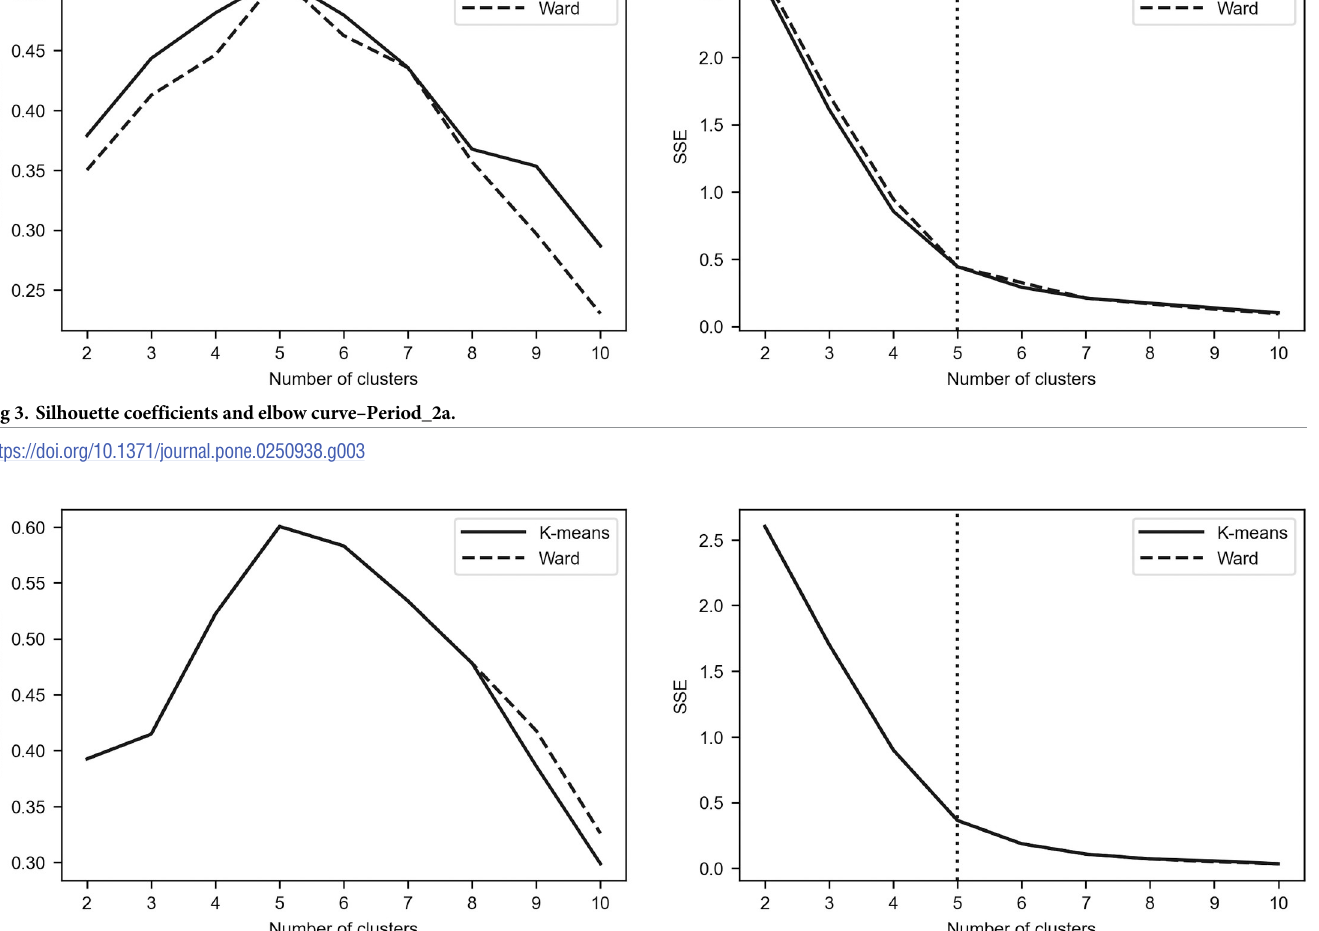
PLOS ONE | https://doi.org/10.1371/journal.pone.0250938 May 20,